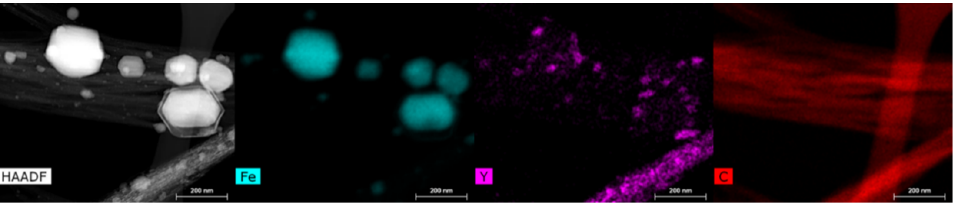
Figure 5. HAADF imaging and EDX mapping of CNT bundles showing the Yttria distribution on CNT wall.